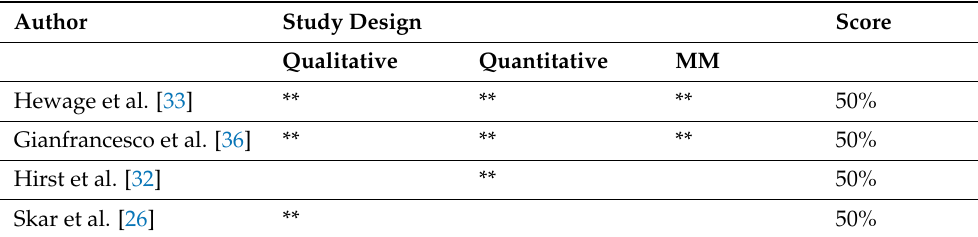
Table 2. Summary of quality assessment for included qualitative, quantitative, and mixed method studies using the Mixed Methods Appraisal Tool (MMAT) version